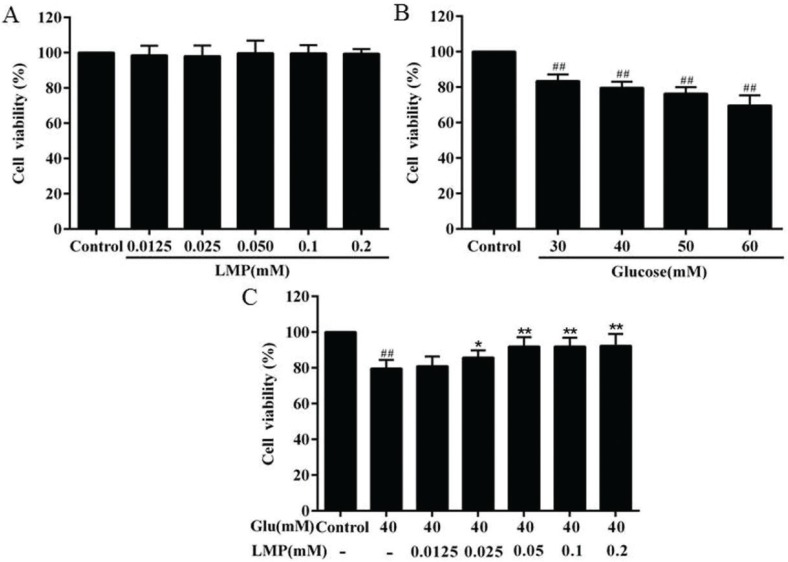
Protective effects of LMP on cell viability losses in MIN6 cells induced by glucose. (A) MIN6 cells were incubated with 0.0125, 0.025, 0.050, 0.1, 0.2 mM LMP for 48 h. Then the cell viability was evaluated by MTT assay. (B) The MIN6 cells were treated with glucose at different concentrations (30, 40, 50 and 60 mM) for 48 h. The cell viability was evaluated by MTT assay. (C) Protective effects of LMP on cell viability losses in MIN6 cells induced by 40 mM glucose. The untreated normal cells (control group) were assigned values of 100% and data are expressed as the mean ± standard deviation. ##P < 0.01 vs. control group, *P < 0.05, **P < 0.01 vs. group treated with glucose.